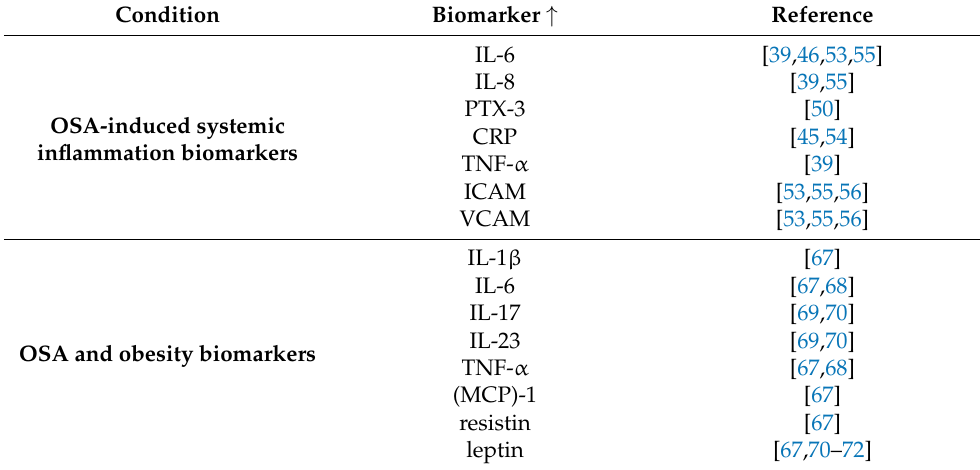
Table 1. List of elevated biomarkers reported in studies involving patients with